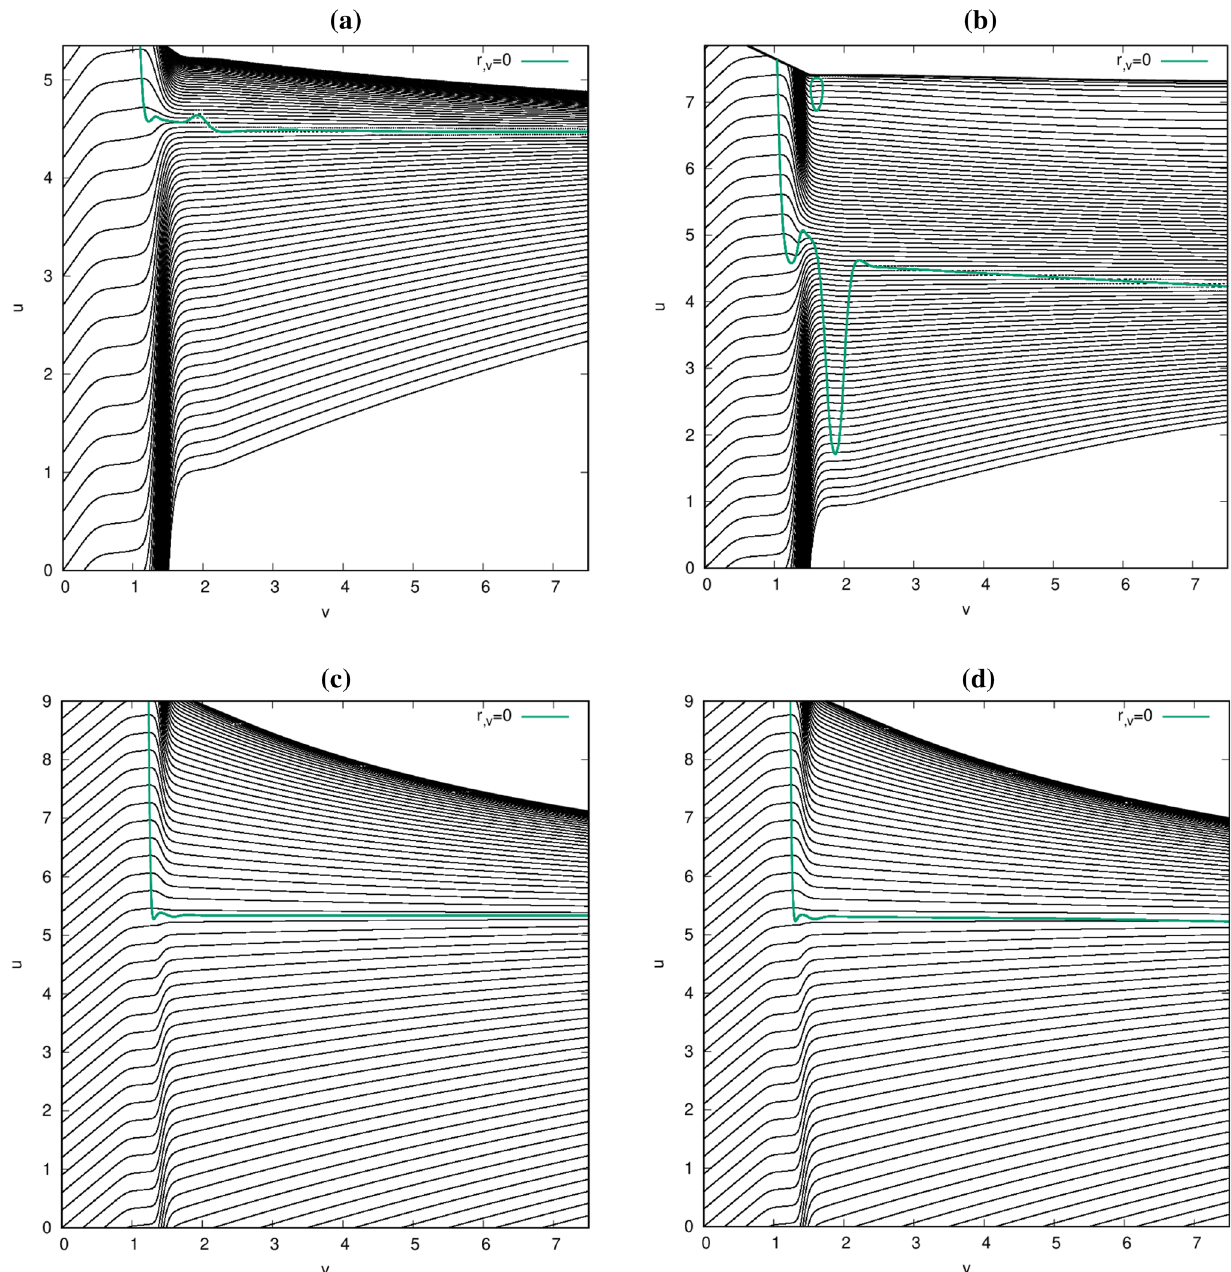
Fig. 10 Penrose diagrams of spacetimes emerging from evolutions with one non-zero scalar–gravity coupling constant. The parameters λ X and λ hX wereequalto0 . 1and10 − 6 ,respectively.Theremainingparam- eters were a m 2 = 0 . 25, ξ X = − 1, ξ h = 0, α m = 0, ˜ p X = ˜ p h = 0 .